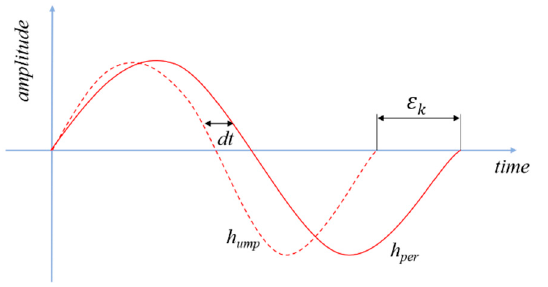
Figure 11. Schematic diagram of trace stretching method.